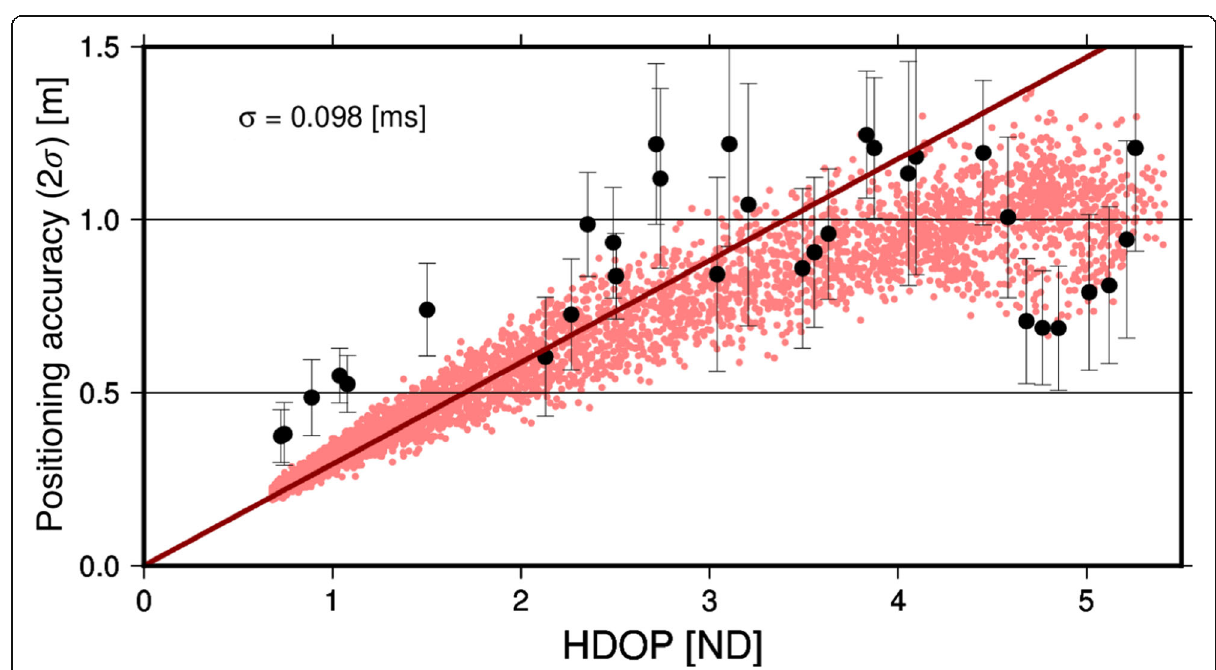
Fig. 9 Relationship between HDOP and σ H The black and light red dots represent deviations in array positions determined using the buoy observation data (illustrated in Fig. 4) and synthetic test results (illustrated in Fig. 8) corresponding to the HDOP. The red line illustrates a linear function obtained (Eq. (13)) using a scaling factor